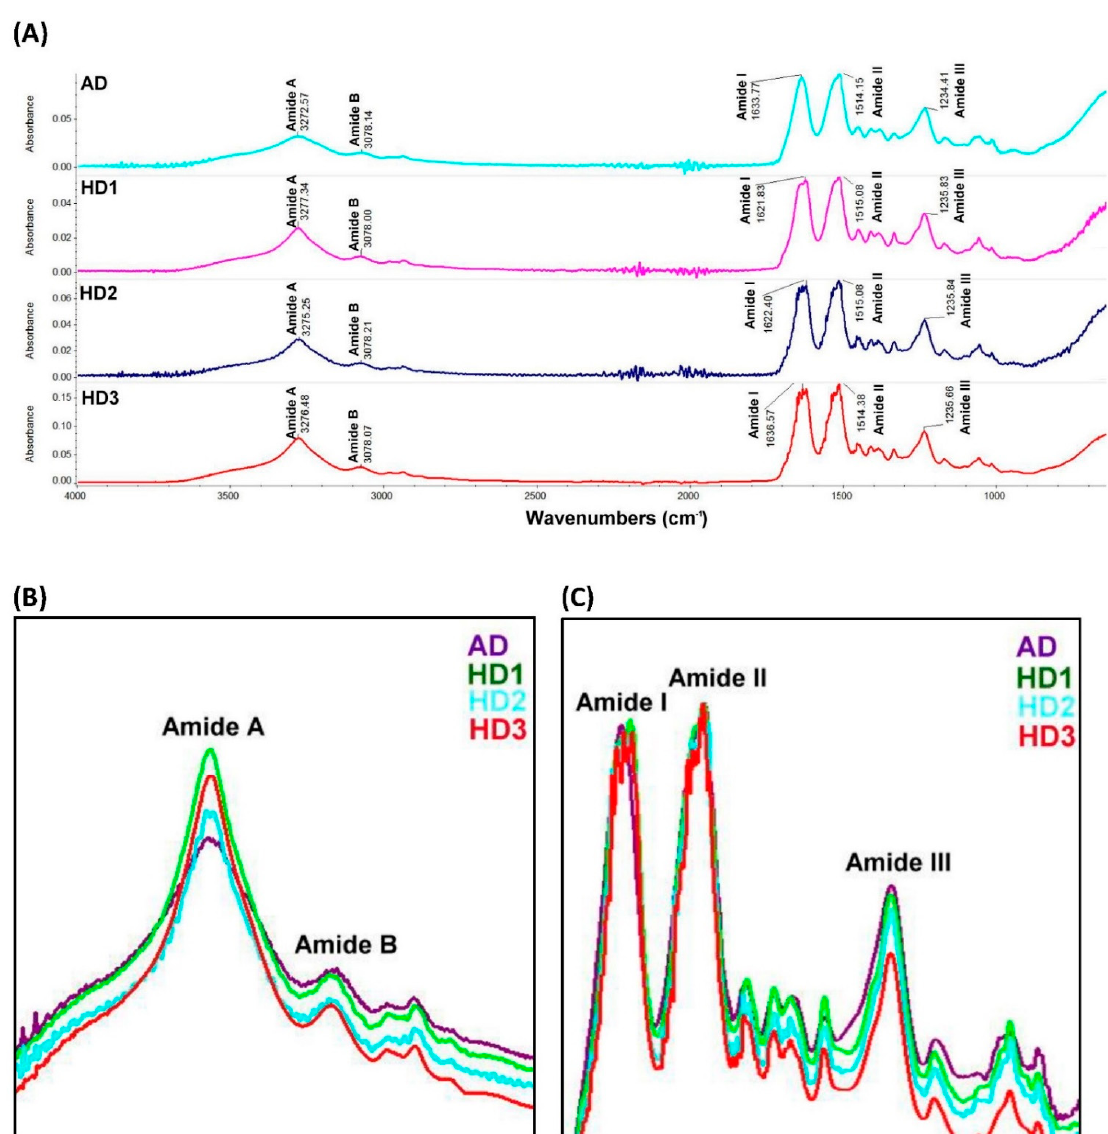
Figure 4. FTIR spectra of B. mori silk fibroin film prepared from alkaline degumming (AD) and heat degumming (HD1, HD2, and HD3) procedures. ( A ) Merged FTIR spectra of AD and HD1–3 SF-films. Overlapping spectra curves of the amide A and amide B bands ( B ), and amide I, amide II, and amide III bands ( C ) from AD and HD1–3 SF-films.